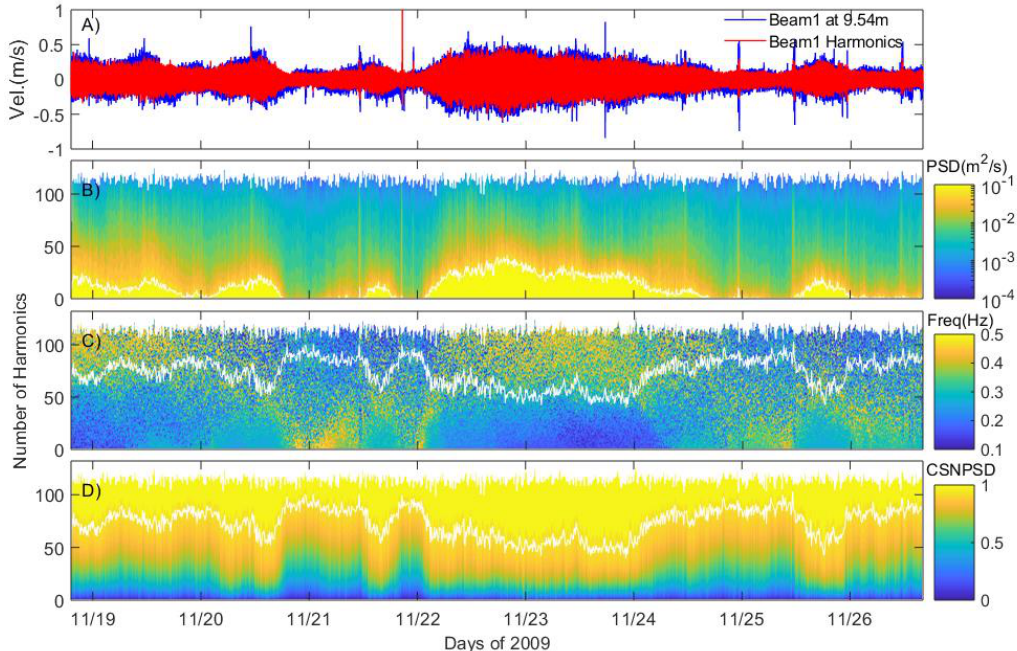
Figure 3. ( A ) Beam1 velocities (blue line) and wave orbital velocities (red line) computed by the Harmonic Analysis (HA) method; ( B ) PSDs (m 2 /s) of the peaks sorted by descending order; and 0.08 PSD (m 2 /s) in the white line ( C ) Frequencies corresponding with the sorted PSDs and ( D ) Cumulative Sum of Normalized Power Spectral Density (CNPSD). In both C and D, the white line represents the number of harmonics with 95% energy.